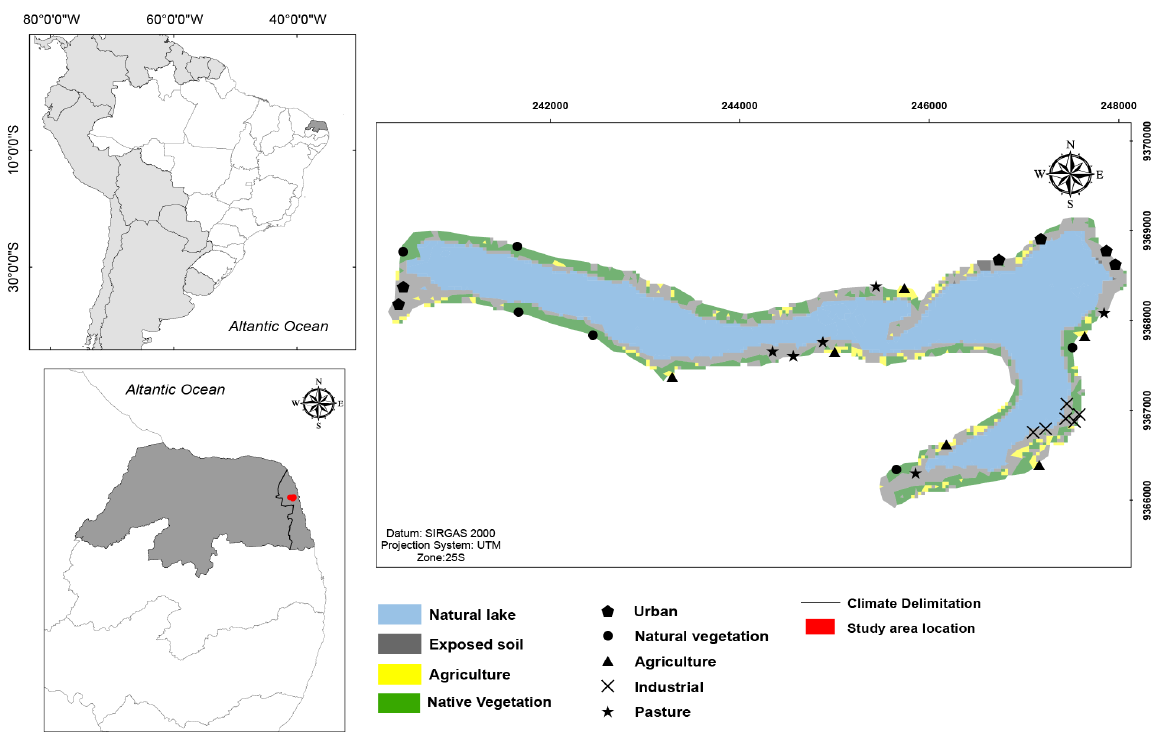
Figure 1. Study area, land use, and sampling points in the riparian zone of Extremoz Lake, Rio Grande do Norte, Brazil. The line depicts the climate delimitation. To the right of the line is the humid tropical region and to the left is the semi-arid